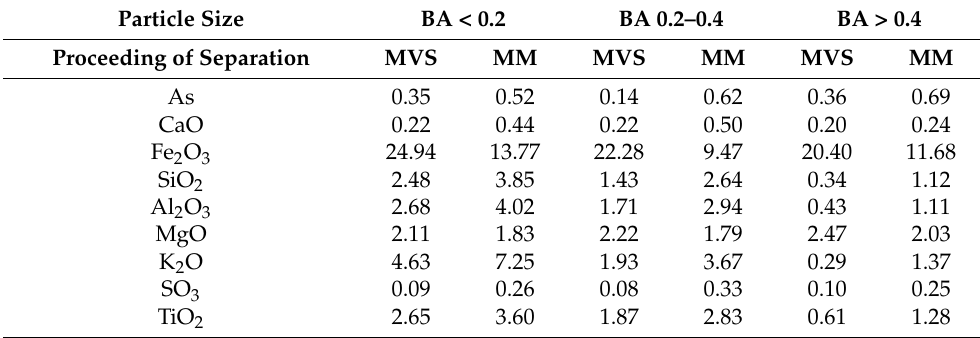
Table 3. Enrichment factors of the studied elements in magnetic fractions (vs. non-magnetic